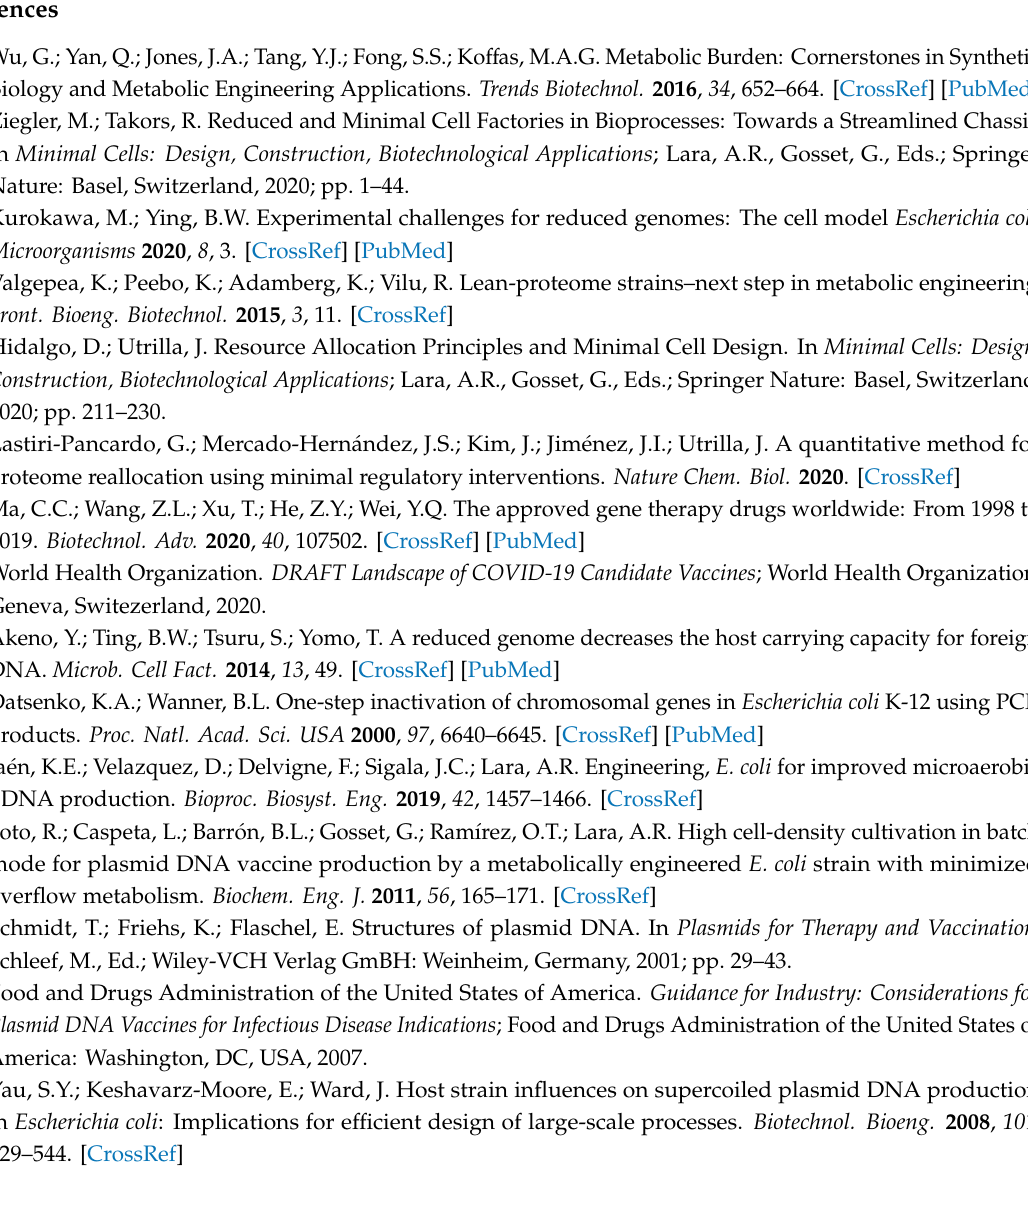
Figure S1. Time profiles of cultures of the wild type (left) and PFC (right) strains in mineral medium. Figure S2. Time profiles of cultures of the wild type (left) and PFC (right) strains in Lysogeny Broth. Figure S3. Time profiles of cultures of the wild type (left) and PFC (right) strains in Terrific Broth. Figure S4. Time profiles of cultures of the wild type (A), wild type ∆ recA (B), PFC (C), and PFC ∆ recA (D) strains in EnPresso B Plasmid medium. Figure S5. Example of agarose gel used for densitometric analysis of the pDNA produced by the proteome-reduced strain. L: pUC57Kan digested with BamHI; 1-3: pDNA samples from triplicate cultures in LB; 4-6: pDNA samples from triplicate cultures in mineral medium; and 7-9: pDNA samples from triplicate cultures in EnPresso B Plasmid